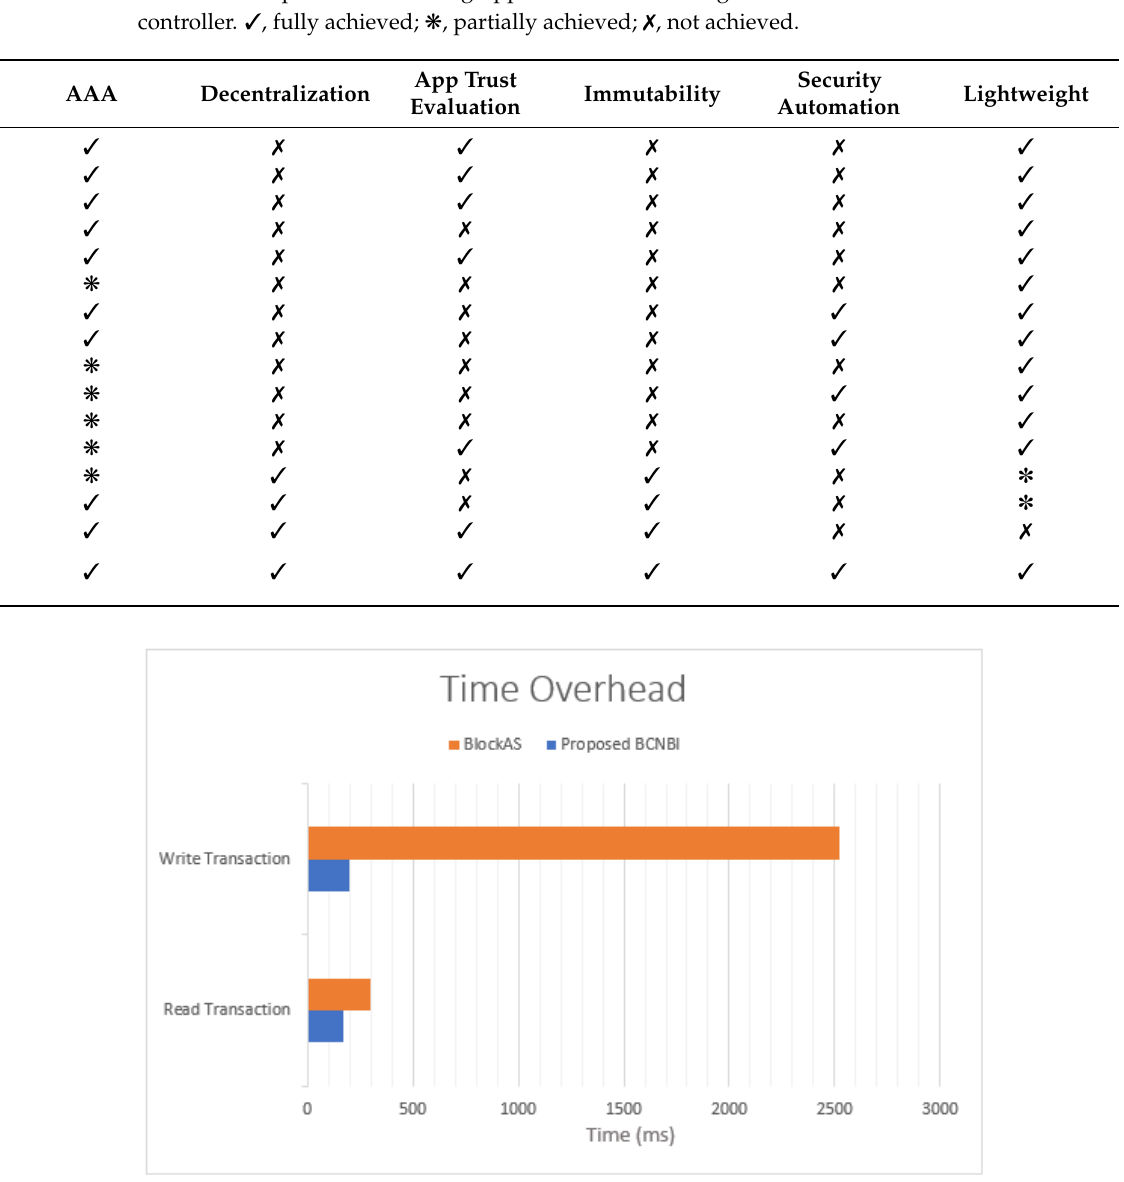
Figure 11. Performance evaluation comparison between proposed framework and BlockAS